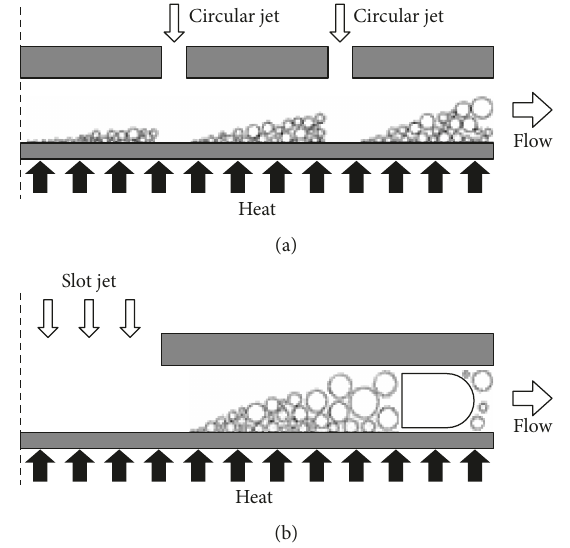
Figure 5: Two di ff erent jets. Multiple circular jets and single-slot jet [33].